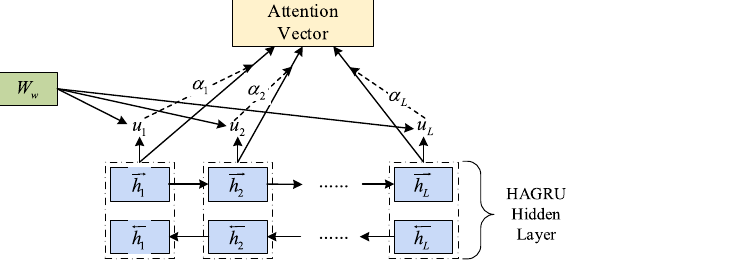
Figure 6. soft attention mechanism of HAGRU